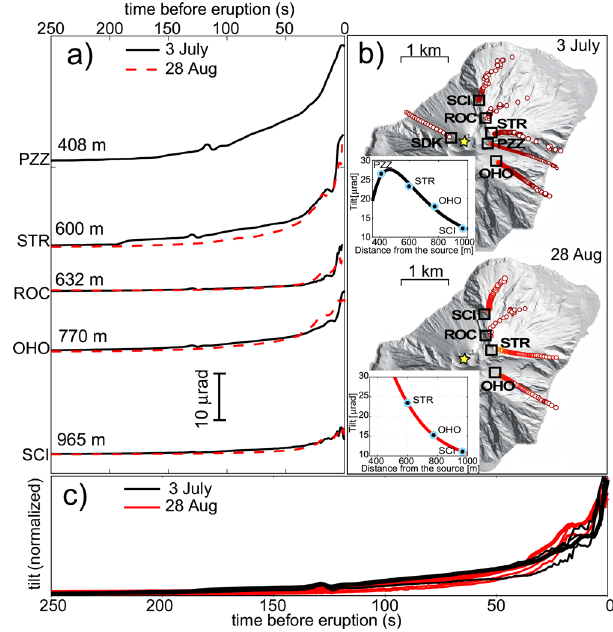
Fig. 1 Ground tilt data for the 3 July and 28 August 2019 paroxysms. a Radial tilts recorded by four broadband seismic stations (PZZ, STR, ROC, and SCI) and the borehole tiltmeter (OHO) of the permanent network (Supplementary Fig. 1) 250s before the onsets of the 3 July 2019 (black line) and 28 August 2019 (red dashed) paroxysms within a distance of 408 – 965m from the vent. b Tilt trajectories associated with the waveforms shown in a showing an almost radial pattern pointing to the crater area for both paroxysms. The best- fi t solutions (open-conduit deformation model 36 ) between the theoretical tilt pattern and observations are shown in the insets and are consistent with volume changes of 4.9×104m 3 and 3.2×10 4 m 3 in the upper 380 and 240m a.s.l. below the vent for the 3 July 2019 and 28 August 2019 paroxysms, respectively. c Normalized radial tilt waveforms corresponding to those shown in a associated with the two paroxysms illustrating how the amplitude ratio between stations remained the same during the 250s before the onset of the paroxysm, suggesting a stationary shallow source. Due to calibration issues at seismic station SDK, the absolute tilt could not be derived; hence, its data were not used in the